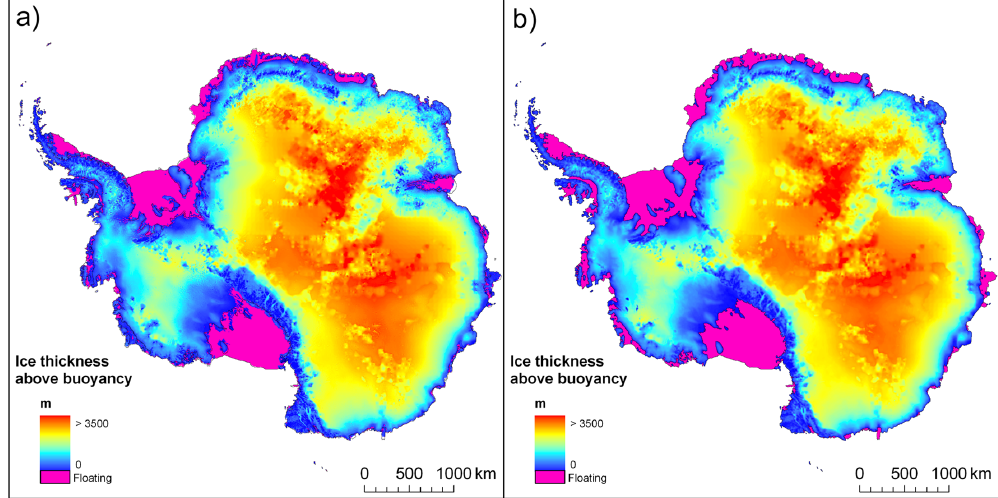
Figure 6. Ice thickness above buoyancy: (a) original BEDMAP dataset and (b) ALBMAP dataset.